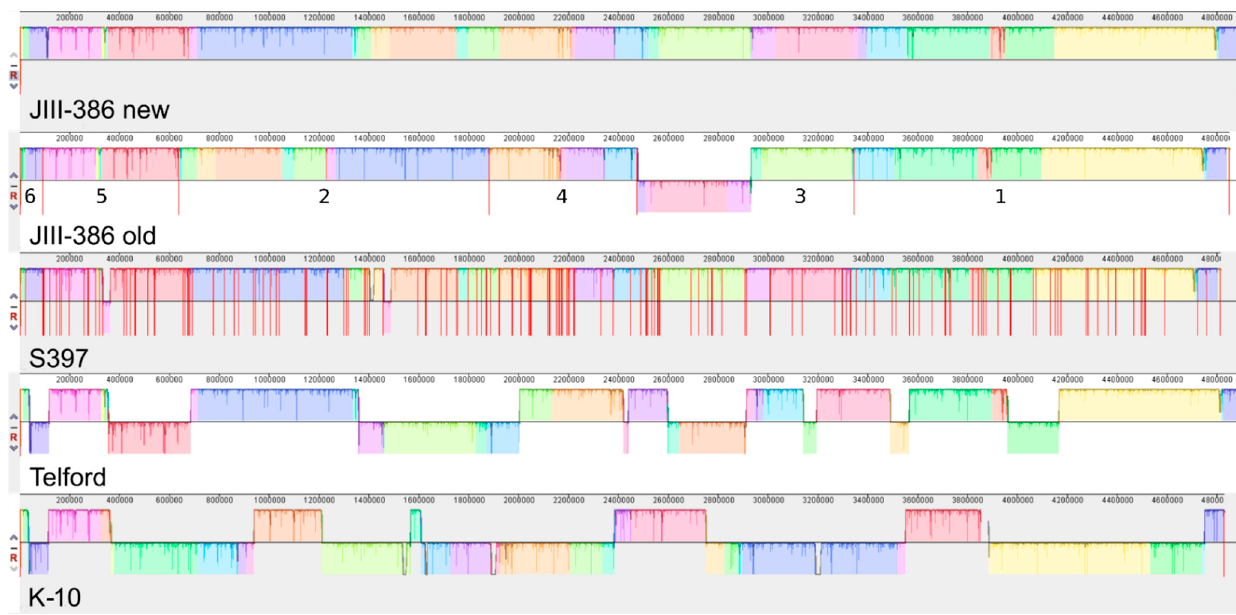
Figure 3. Comparison of new and old versions of JIII-386, S397, Telford, and K-10 using MAUVE 2.4 [53]. The scale is in base pairs. All genomes are compared to a consensus genome generated by Mauve. Identical colored blocks indicate homologous regions, which are internally free from genomic rearrangements. Blocks below the centerline are aligned reverse complementary. Darker lines within each box represent regions that differ in comparison to the consensus sequence, with longer lines being more different than shorter lines. Long red lines demonstrate the gaps in JIII-386 old and S397 draft genomes. The six scaffolds in JII-396 are numbered in descending size order. The start of the dnaA gene is localized at 0 kb.